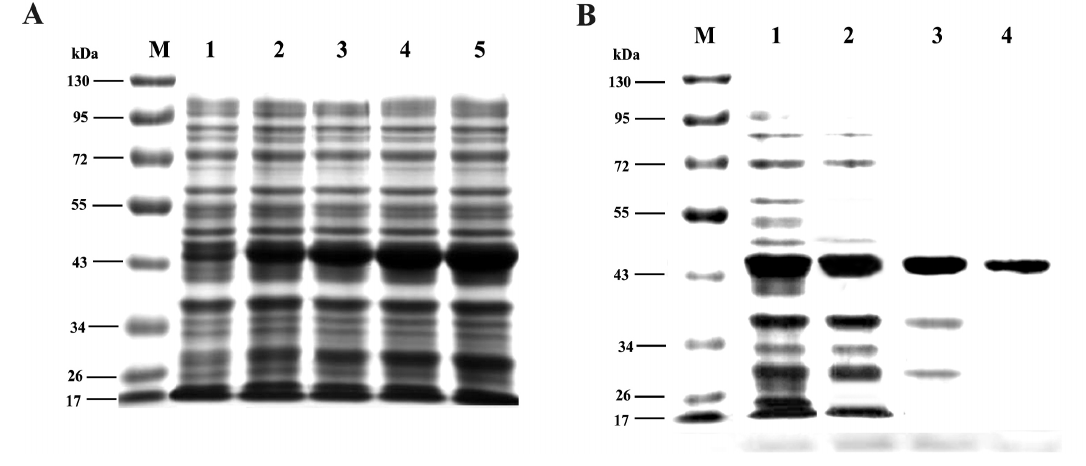
Figure 6. The expression and purification of Trx-TAT-Ferritin recombinant protein. ( A ) Protein expression of Trx-TAT-Ferritin with different induction time on 1, 2, 4, 6 and 8 h; ( B ) Trx-TAT-Ferritin purification under native conditions, 1. Flow through, 2–4. first to third column